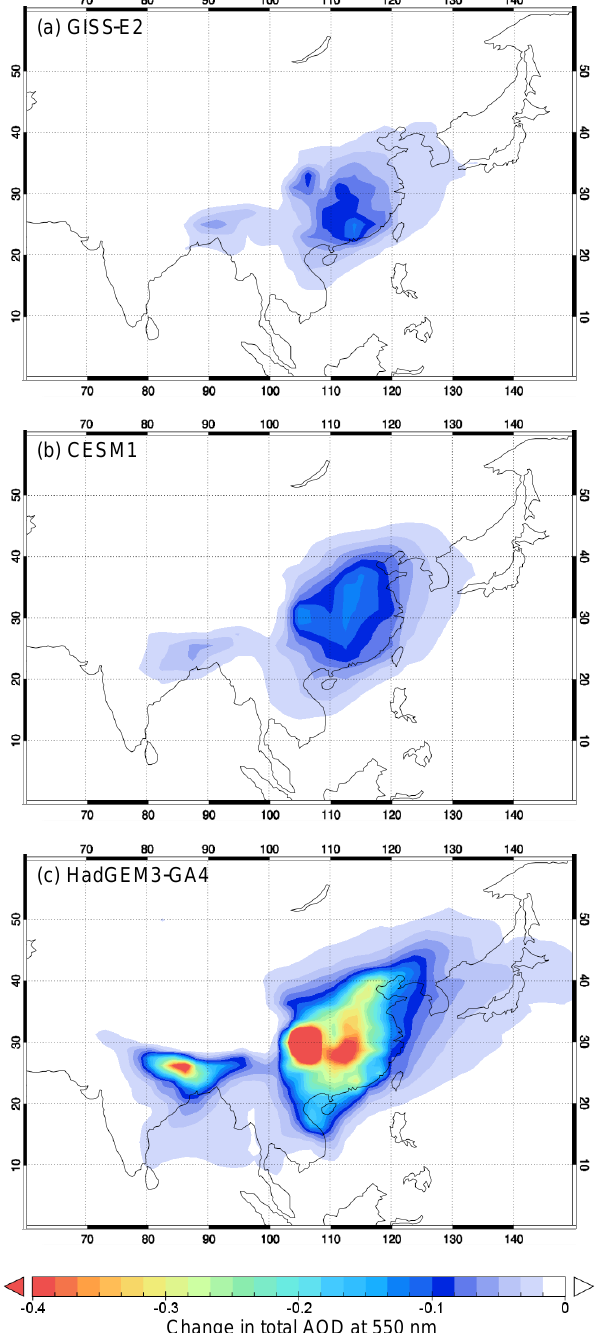
Figure 4. Change in AOD at 550nm due to removing SO 2 emis- sions from China for (a) GISS-E2, (b) CESM1, and (c) HadGEM3- GA4. For HadGEM3-GA4 and GISS-E2, AOD is calculated for clear-sky conditions, whereas for CESM1, AOD is calculated for all-sky conditions, which will generally result in higher values within each simulation. Differences are calculated as the pertur- bation simulation minus the control simulation, averaged over 150 years. The plot region focuses on Asia as changes outside of this domain were